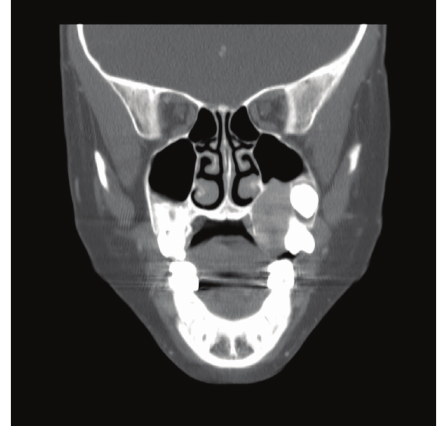
Figure 2: CT scan of the maxillofacial region in coronal view showing a destructive lesion of the left hard palate growing into the maxillary